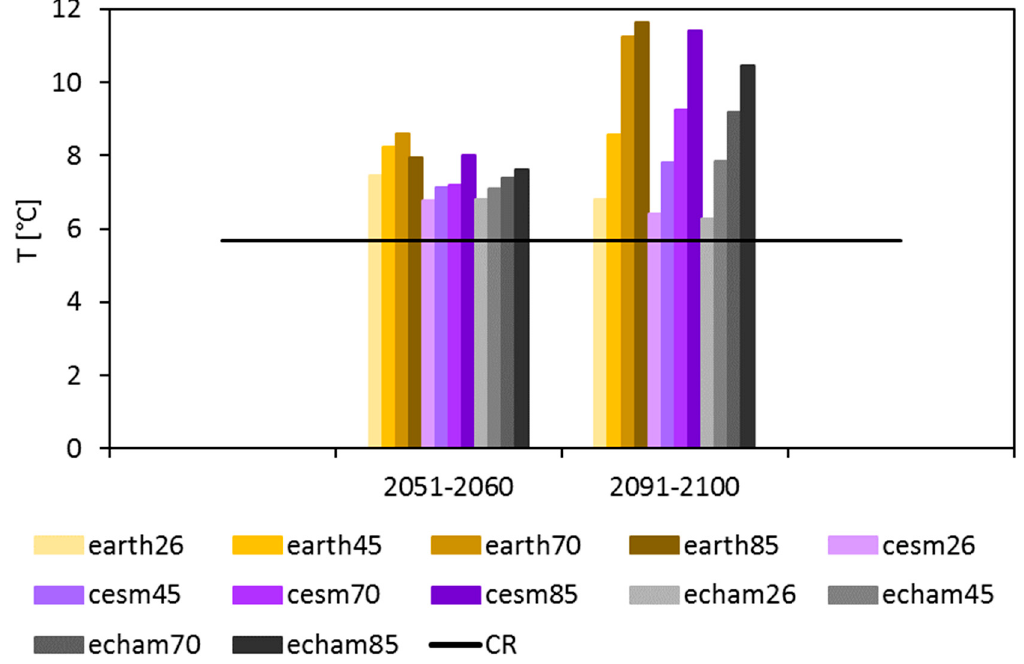
Figure 7. Projected mean temperature of the catchment for each socio-economic pathway (SSP) and each Global circulation models (GCM).